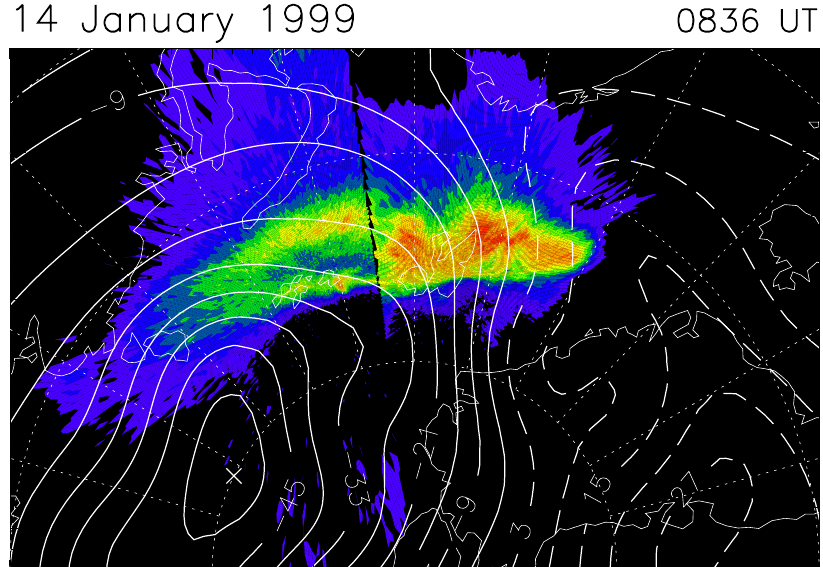
Fig. 10. SuperDARN streamline plot with the 630.0nm aurora superimposed for 08:36UT. The aurora is obtained from all-sky imagers at Heiss Island, Russia and Ny ˚Alesund, Svalbard. The red line emission is projected to an altitude of 250km. The coordinate system is